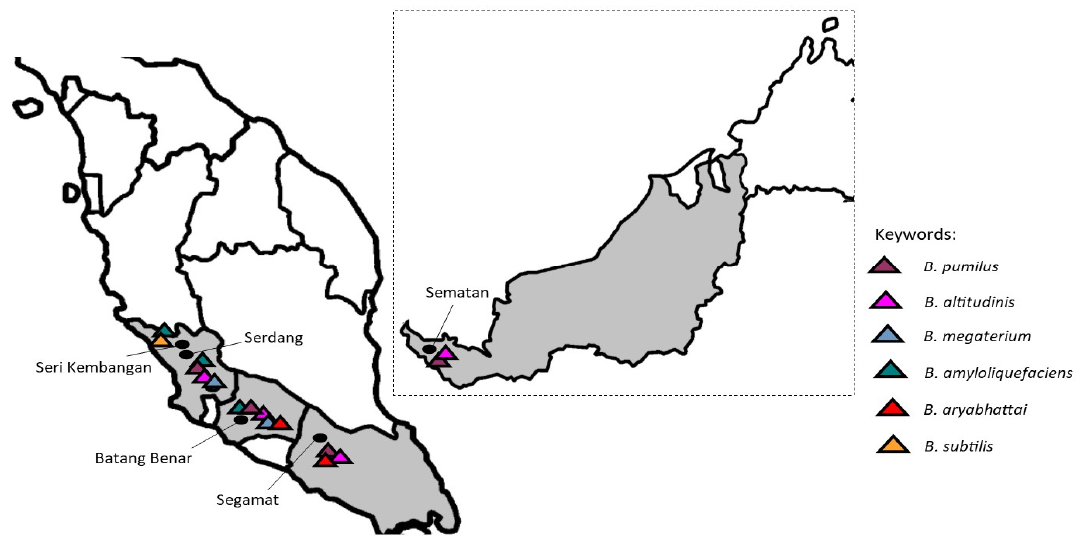
Figure 2. Distribution of the Bacillus species isolated from stingless bee ( Heterotrigona itama ) honey from different geographical locations.